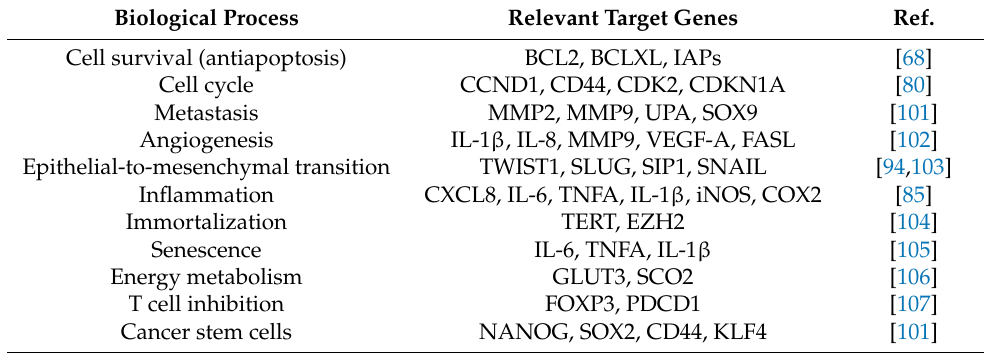
Table 3. Some cancer-relevant biological processes and relevant target genes controlled by NF- κ